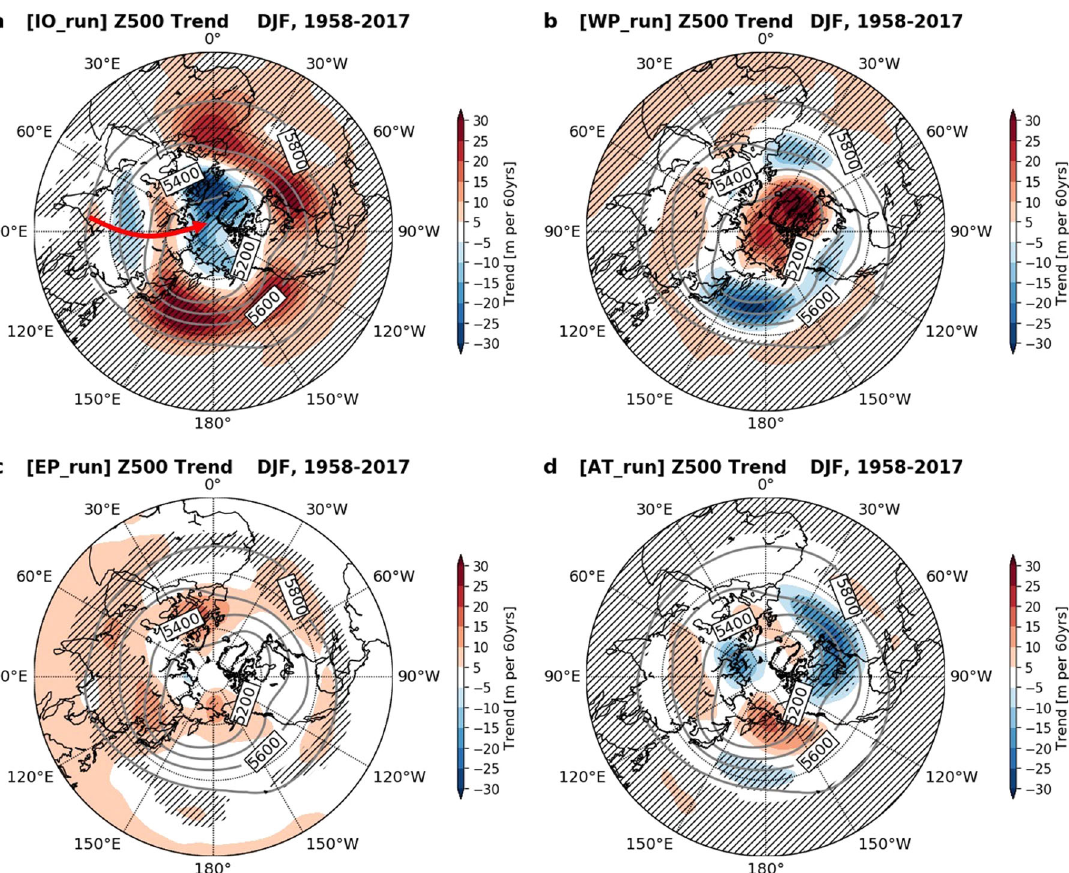
Fig. 4 Long-term trends of 500hPa geopotential height in each pacemaker experiment using GRIMs. The linear trends of 500hPa geopotential height (Z500) (shading) in ( a ) IO, ( b ) WP, ( c ) EP, and ( d ) AT runs with the climatological (1958 – 2017) Z500 (contour, unit: meter). The black hatched regions indicate statistically signi fi cant regions at a 95% con fi dence level. The red arrow in Fig. 4a indicates stationary wave anomalies from the northern Indian continent to Arctic